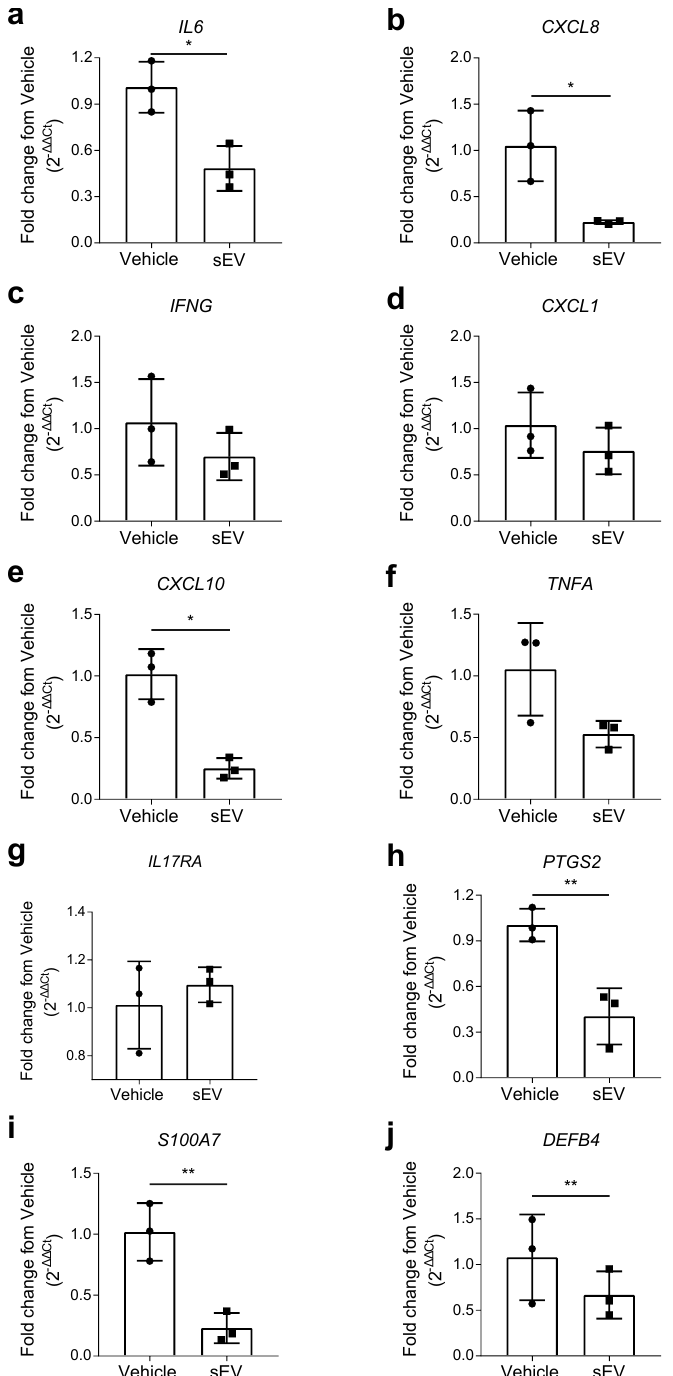
Figure 3. Decreased expression of epidermal psoriatic features after UCB-MNC-sEV treatment. Relative expression of ( a – h ) pro-inflammatory mediators and ( i , j ) anti-microbial peptides by a 3D model of human psoriatic epidermis, treated with 1 × 10 10 particles/mL UCB-MNC-sEV twice daily for 6 days ( n = 3). All results are presented as mean ± SD. * p ≤ 0.05, ** p ≤